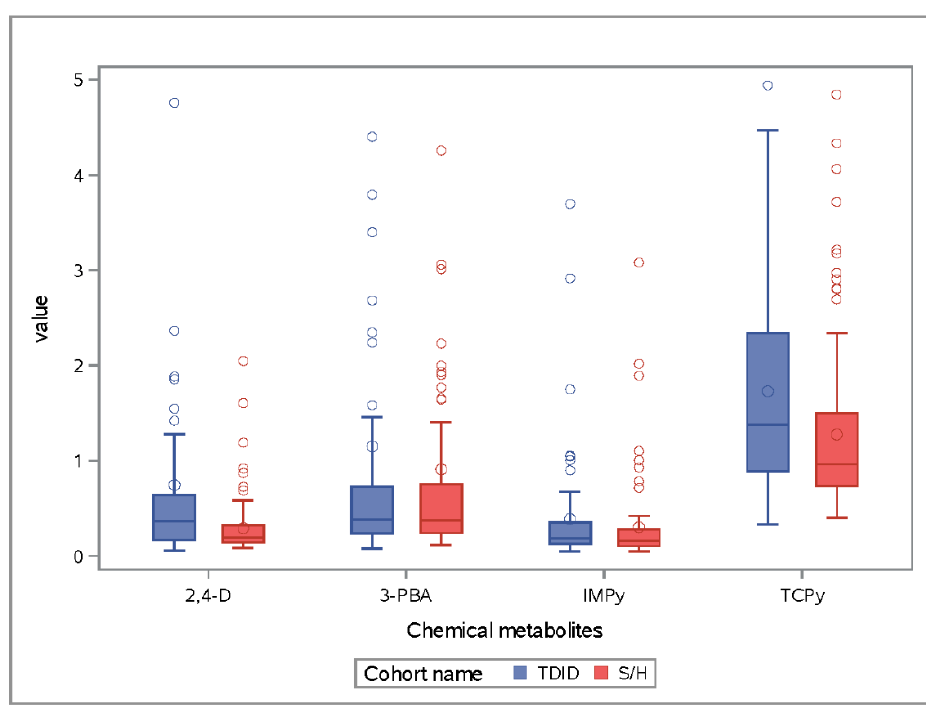
Figure 1. Comparison of concentrations of four metabolites of organophosphate, pyrethroid pesticides and 2,4-D herbicide by cohort .